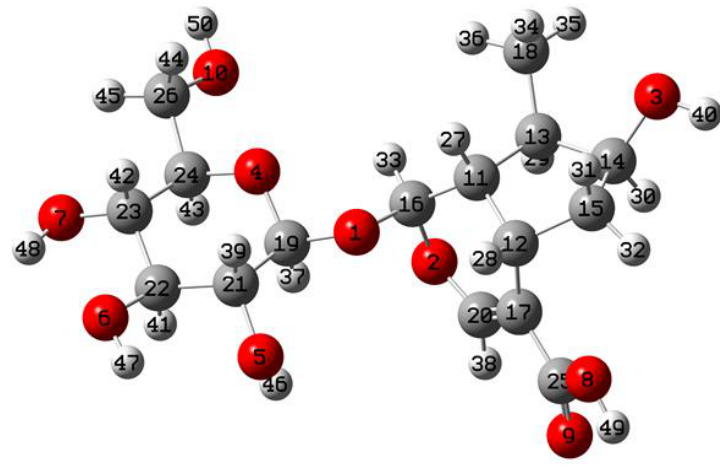
Figure 1. Molecular structure of loganic acid with numbering of atoms.